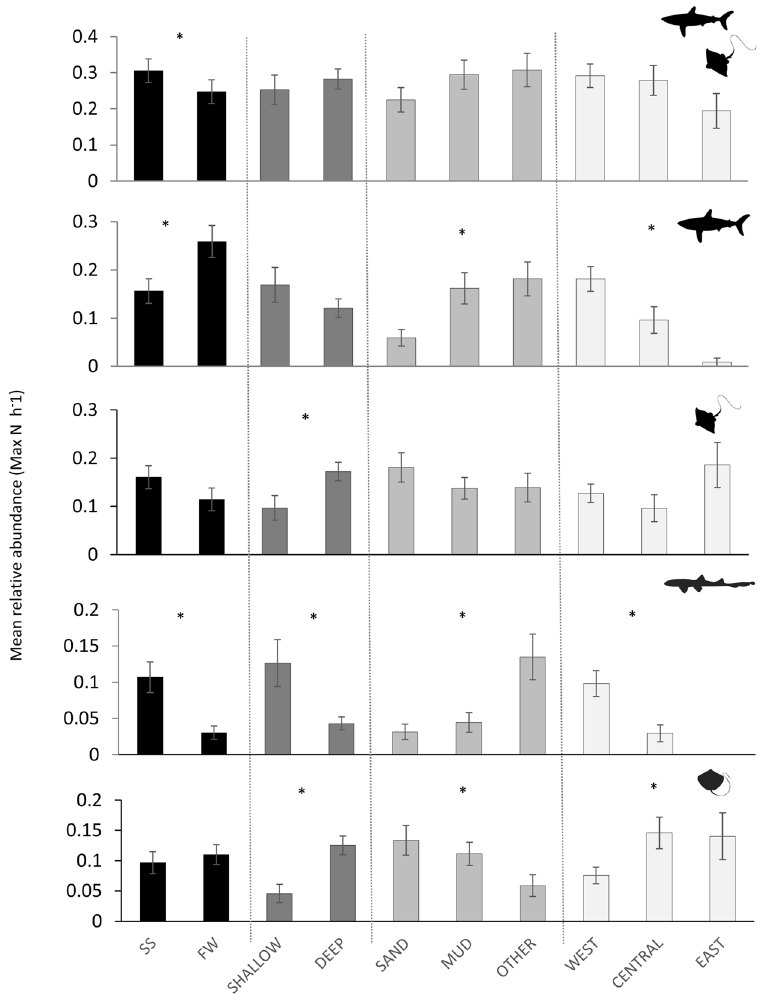
Figure 6. Mean relative abundance (MaxN h − 1 ± SE) of Elasmobranchs, Sharks, Rays, Arabian carpetshark Chiloscyllium arabicum , and stingrays Himantura spp. determined by baited underwater video surveys in relation to Season (SS: Spring/Summer, FW: Fall/Winter), Depth (Shallow: ≤ 10 m, Deep: > 10 m), Habitat (Sand, Mud, Other), and Strata (West, Central, East). * Indicates a significant difference (p < 0.05) between